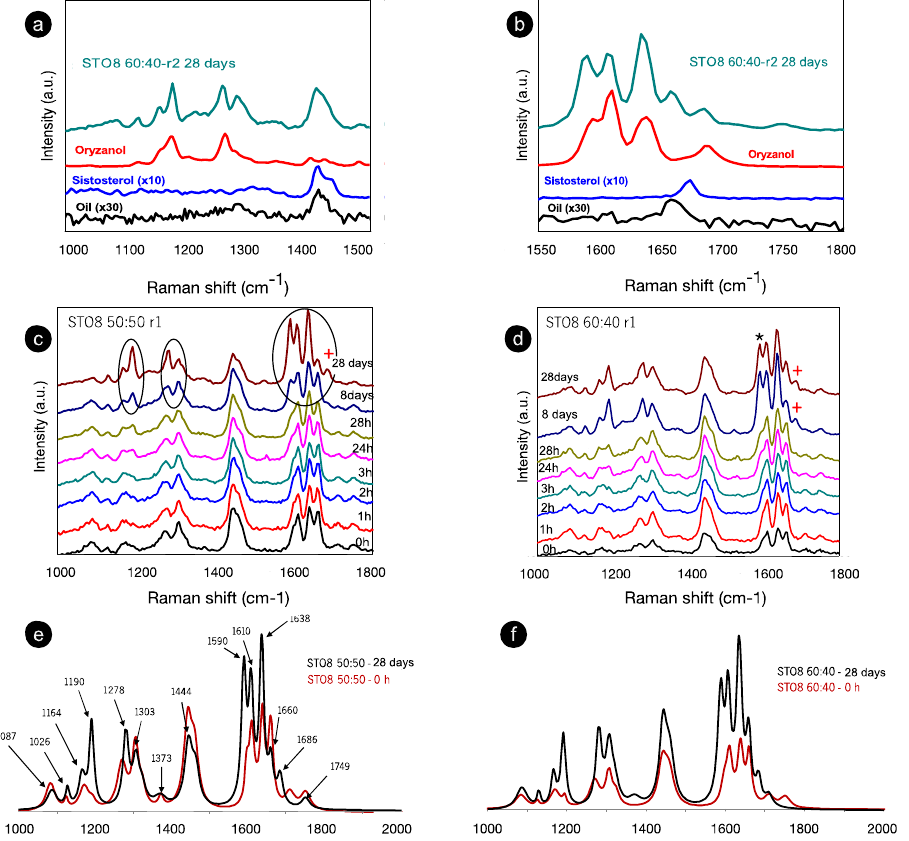
Figure 2. Room temperature Raman spectra for ( a ) a range of 1000–1550 cm − 1 and ( b ) a range of 1550–1800 cm − 1 of the recorded spectra for the oleogelator powders ( γ -oryzanol and β -sitosterol), oil sample (HOSO), and oleogel sample (STO8 60:40) after 28 days. ( c ) STO8 50:50-r1 and ( d ), STO8 60:40-r1 at different storage times. ( e , f ) represent the corresponding first (0 h) and last (28 days) recorded spectra; mode at ≈ 1590 and ≈ 1686 cm − 1 marked with (*) and (+)